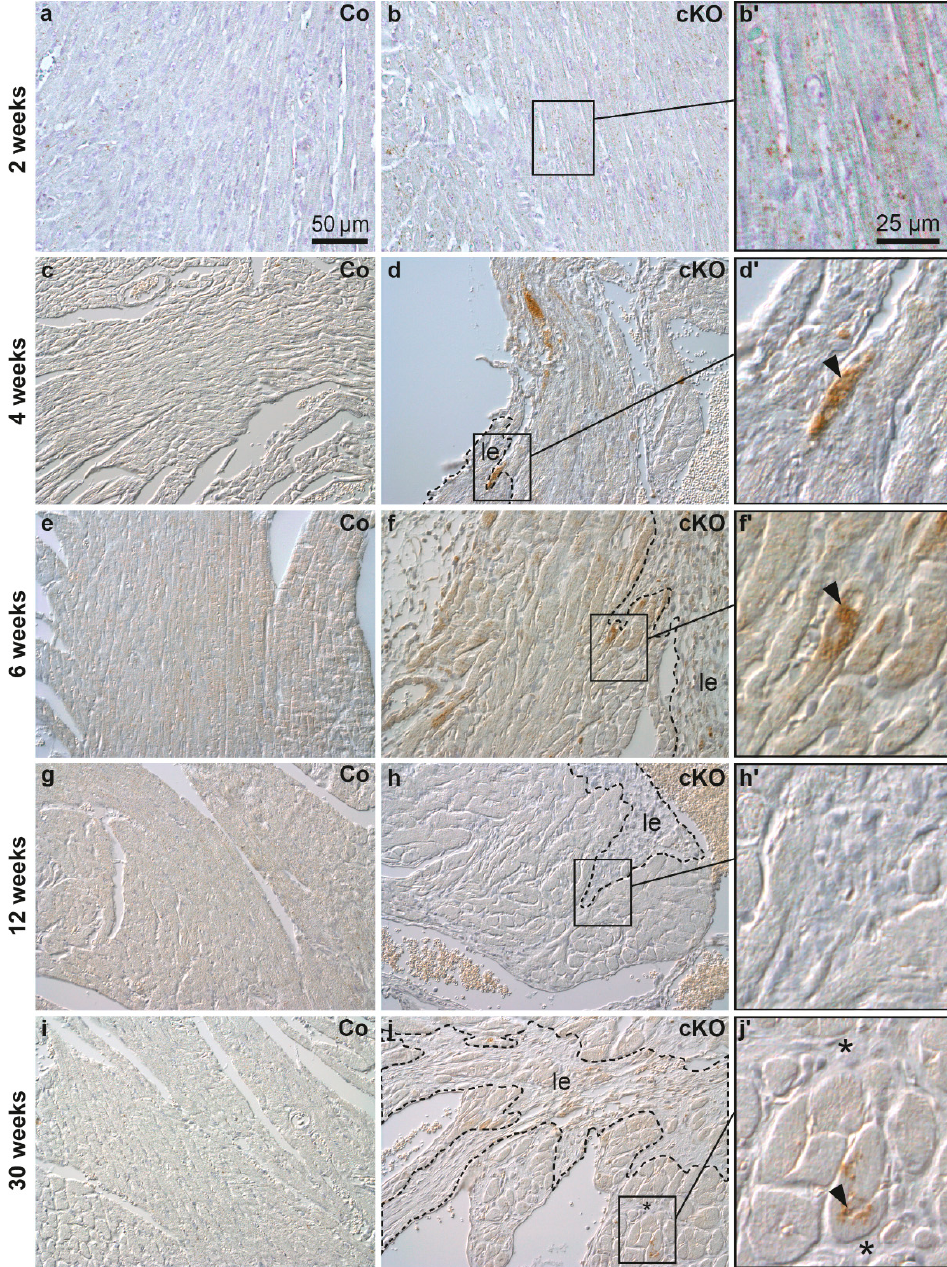
Figure 1. LC3-positive cardiomyocytes are detected near fibrotic lesions during structural disease onset and disease progression in Dsg2 knock-out hearts. The figure shows representative micrographs taken from left ventricles. Myocardial LC3 staining is depicted using interference contrast microscopy. Left column: homozygous Dsg2 flox(E4 − 5) control mice (Co; a,c,e,g,i ); middle and right columns: Dsg2 cKO mice (cKO). At the age of 2 weeks, circularly arranged cardiomyocytes of Dsg2 cKO mice present more LC3-positive granular dots than those of the wild type. The LC3-positive vacuoles are distributed throughout the cell body ( b , b ′ ). At 4–6 weeks, cardiomyocytes located in close proximity to the forming scar tissue (demarcated with a dotted line, le) contain densely-packed LC3-positive granules (arrowheads; ( d , d ′ , f , f ′ )). At 12 weeks, hardly any LC3-positive granules are detectable in Dsg2 cKO cardiomyocytes ( h , h ′ ), but at 30 weeks LC3-positive granules are clearly present in cardiomyocytes lining interstitial (* in ( j , j ′ )) or replacement fibrosis (le, marked by dotted lines in ( j )). Scale bars: 50 µm in a (same magnification in entire left and middle column), 25 µm in ( b ′ ) (same magnification in entire right column).